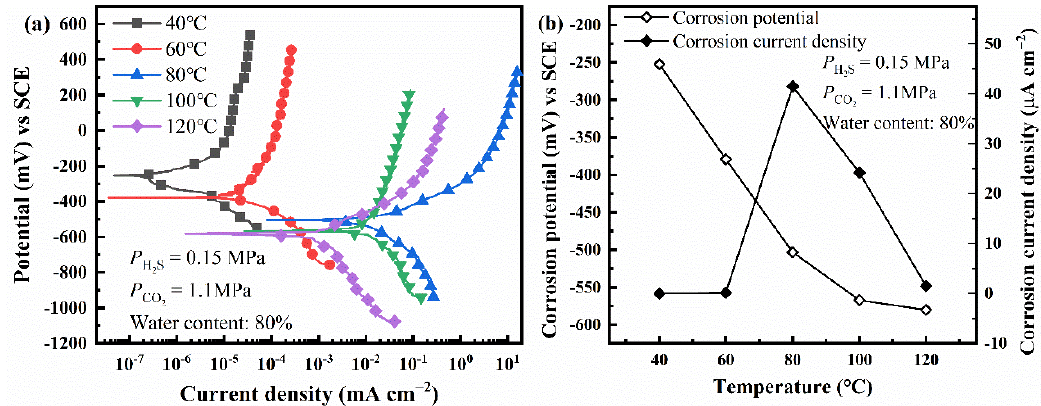
Figure 3. Polarization curves ( a ) and fitting results ( b ) of L80 steels under different temperature.